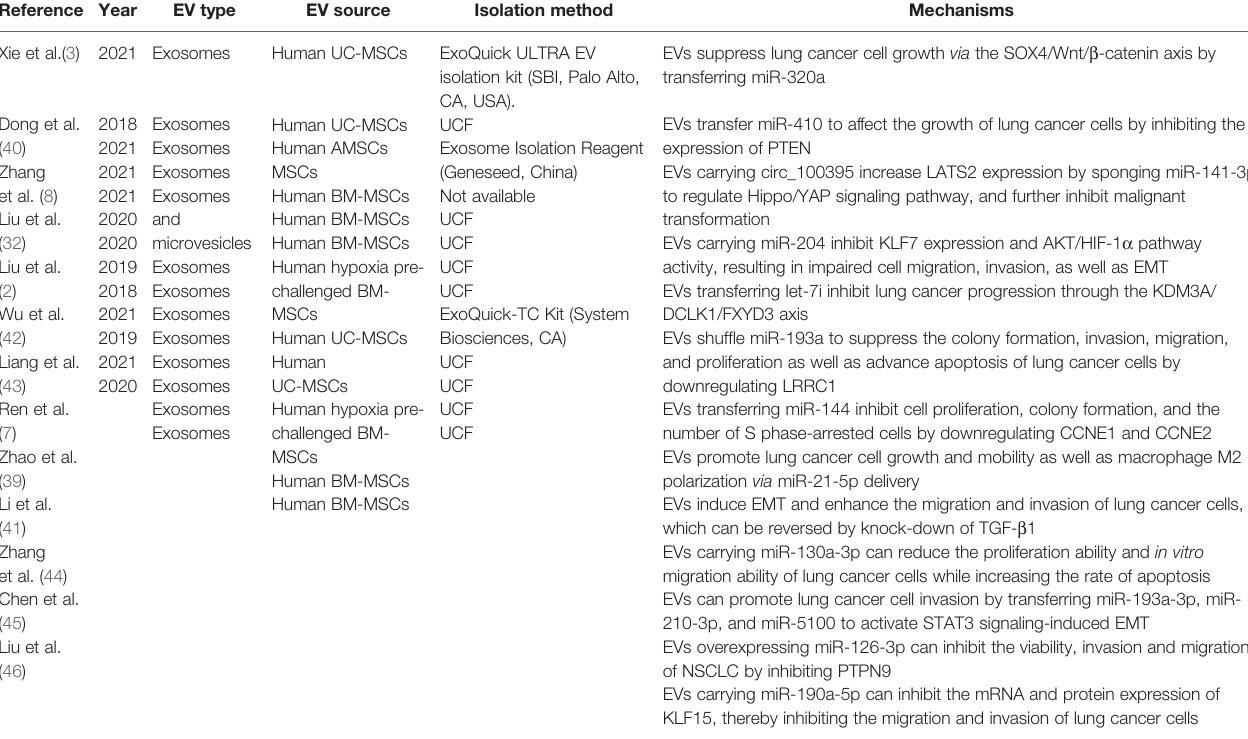
TABLE 2 | Functions of MSC-derived EVs in preclinical models of lung